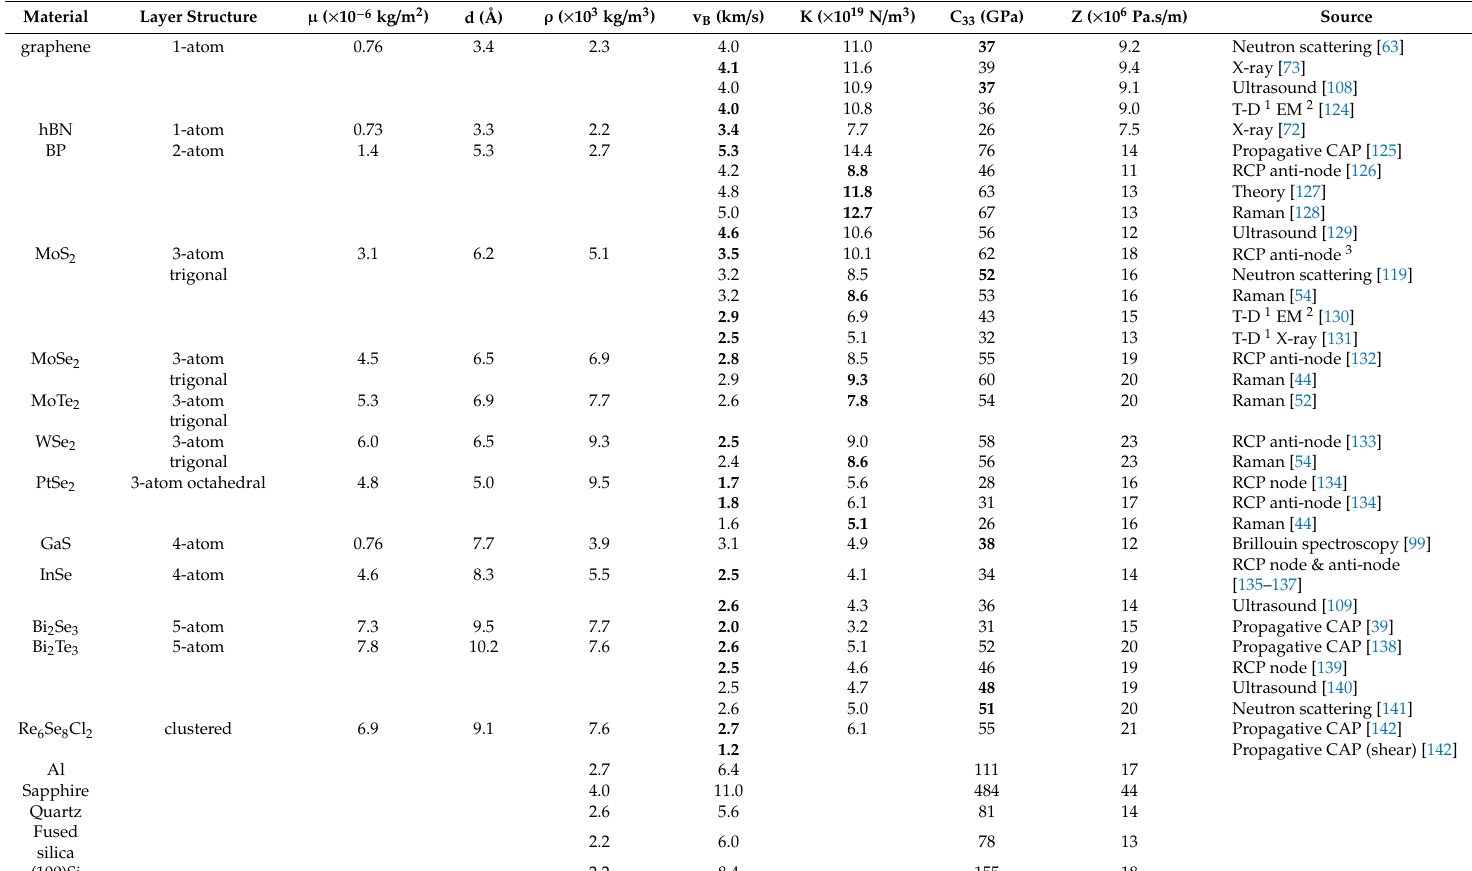
Table 1. Structural and mechanical parameters defined in the main text for a subset of relevant van der Waals materials. Values in bold are the one extracted from the indicated reference, and other mechanical parameters are deduced using Equations (1), (3) and (10). Values for non-layered materials used as substrate or capping layer in literature are also